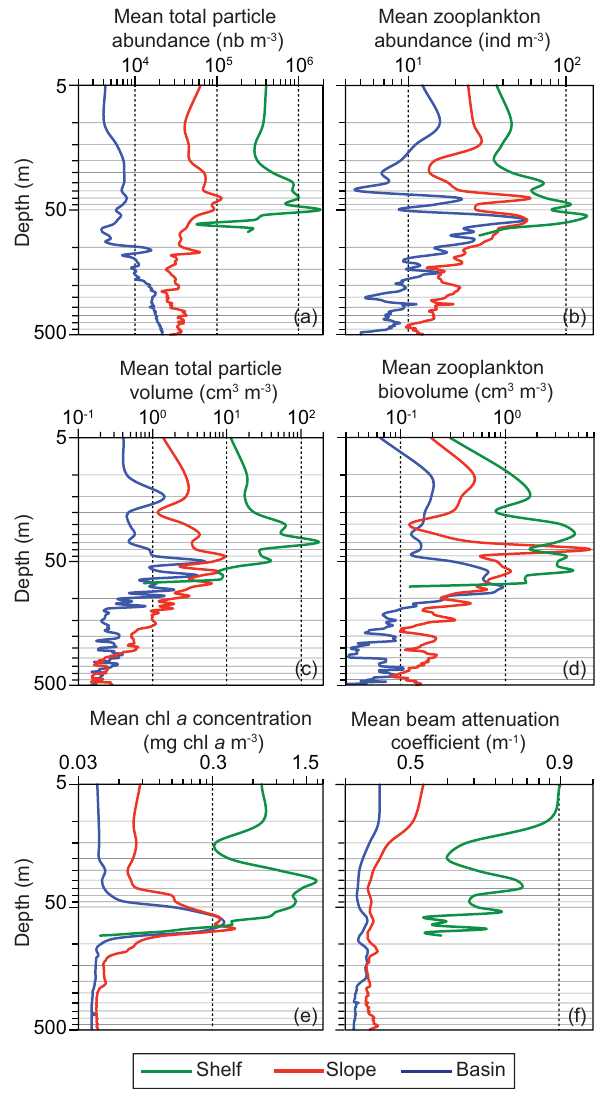
Fig. 2. Mean vertical profiles of total particle abundance (a) , to- tal zooplankton abundance (b) , total particle volume (c) , and to- tal zooplankton biovolume (d) , as measured with the Underwater Vision Profiler deployed across the shelf ( < 100m), slope (100– 1000m) and basin ( > 1000m) areas of southeast Beaufort Sea in July–August 2009 (Fig. 1). The bottom panels present the mean vertical profiles of chlorophyll a concentration (e) and beam atten- uation coefficient (f) as recorded in the same regions and smoothed over 5m